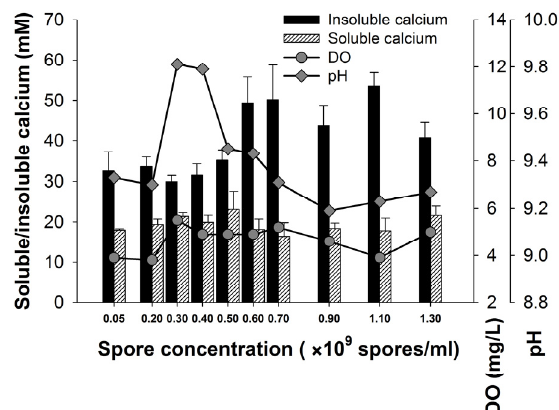
Figure 3. Effect of spore dosage on the calcium precipitation. Figure 2. Effect of spore dosage on the calcium